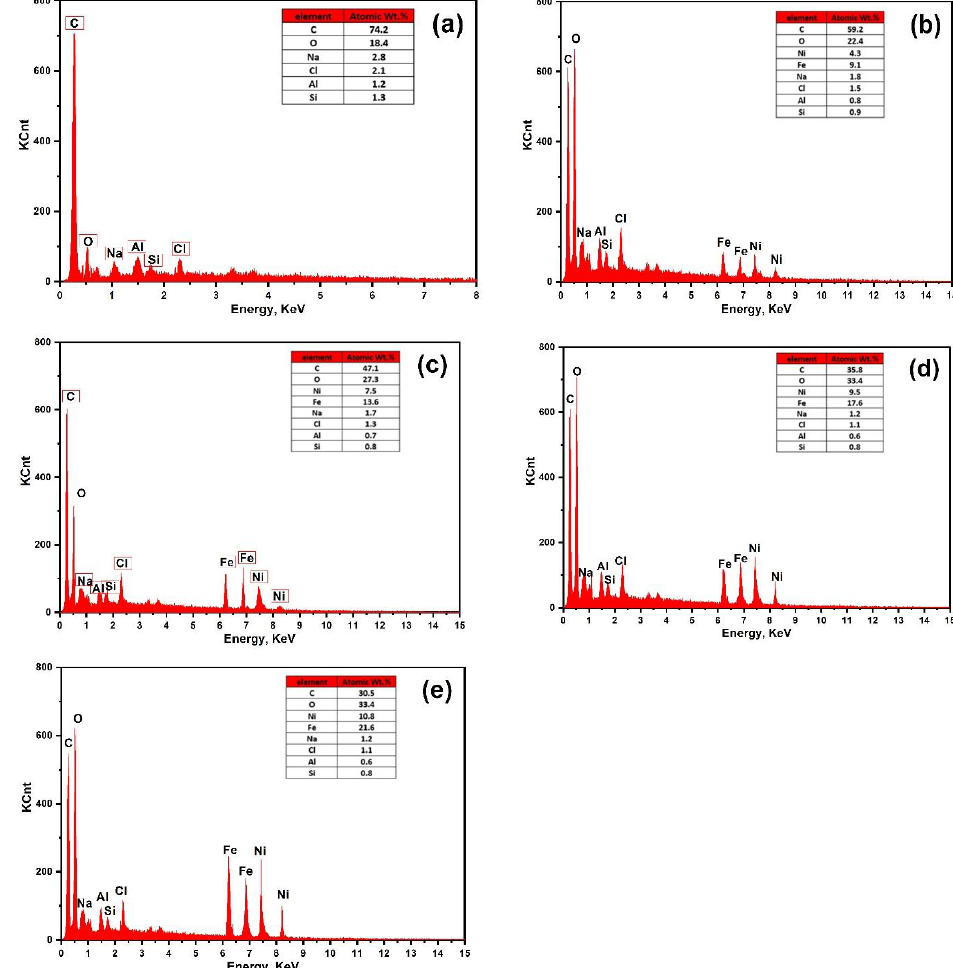
Figure 8. EDX analysis of ( a ) pure AC, ( b ) 10NFAC, ( c ) 25NFAC, ( d ) 45NFAC, and ( e ) 65 NFAC.